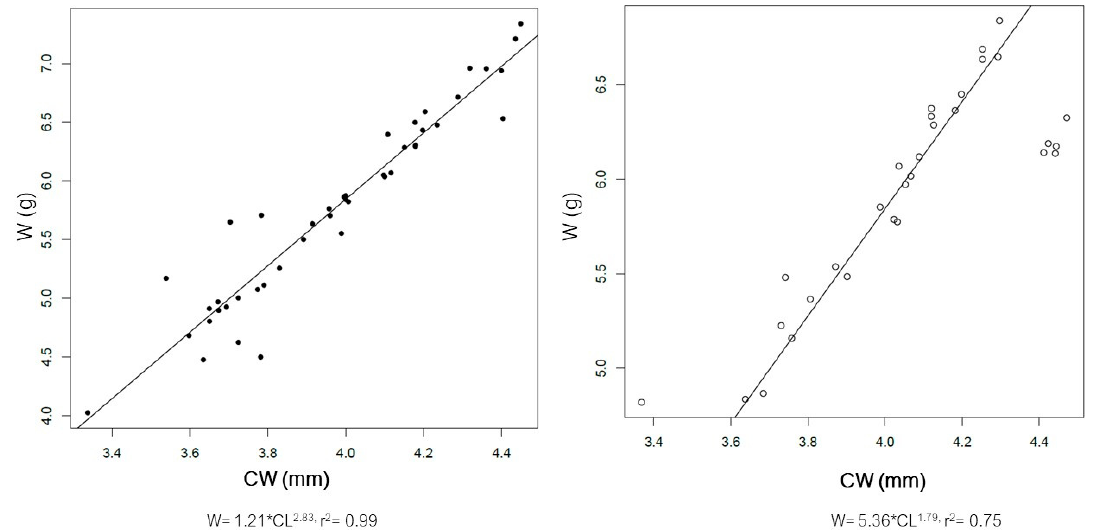
Figure 5. Relationship between carapace width (CW) and weight (W) of the male ( left ) and female ( right ) spiny lobsters Panilurus elephas from the Thermaikos Gulf. The linear regression was performed and plotted with R. Data presented after log-transformation.